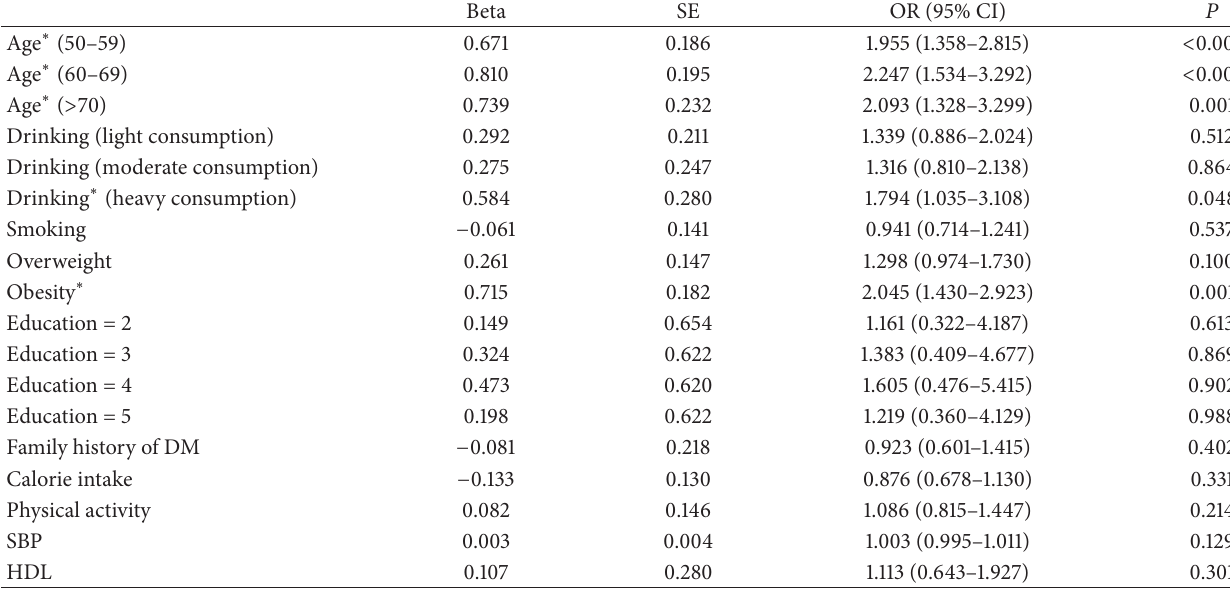
Table 5: Multivariate logistic regression analysis of prediabetes (light, moderate, and heavy alcohol consumption as three separate